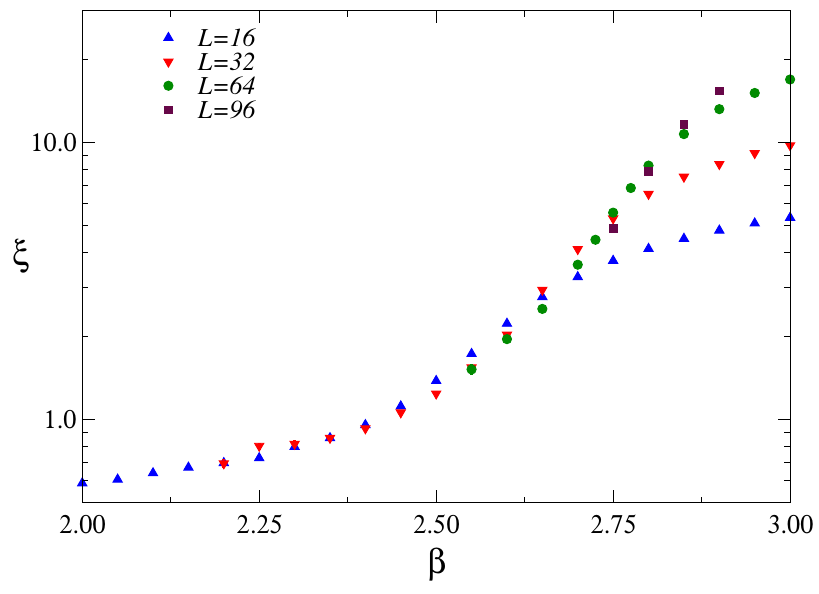
Figure 5 . Correlation length ξ versus β for N c = 2 , N f = 4 , γ = 0 , and v = 10 .